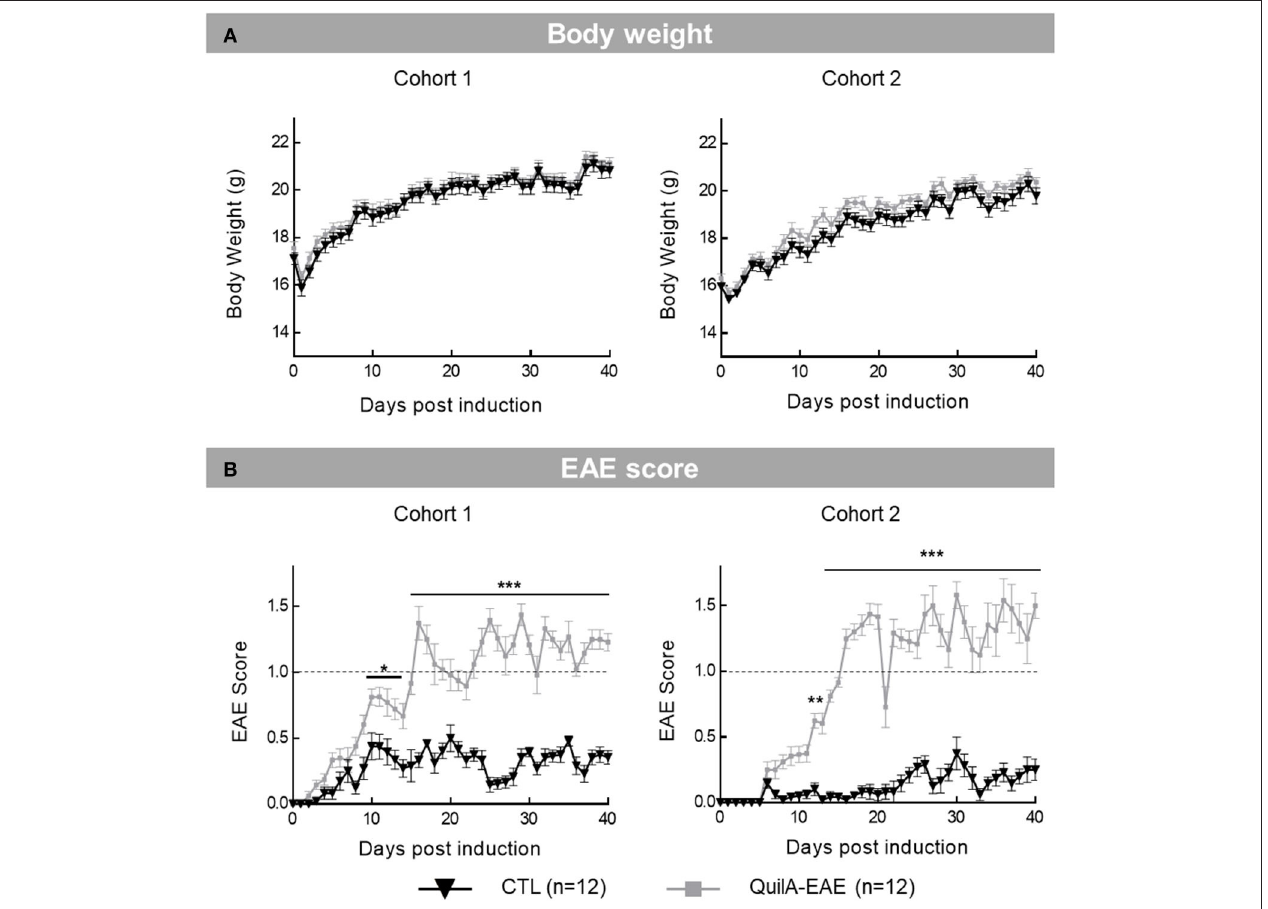
FIGURE 1 | Longitudinal monitoring of body weight and clinical scores in mice immunized with MOG 35 − 55 (QuilA-EAE) and their controls (CTL) from post-induction Day 0 (D0) to D40. (A) Time course of body weight. Results are means ± SEM. (B) Time course of EAE clinical score based on physical observation defined by Khan et al. ( 15) ranging from 0 (normal behavior) to 4 (quadriplegia). Results are means ± SEM. The dashed line represents level of motor defects considered as clinically relevant score (EAE score 1: completely limp tail or hindlimb weakness). Statistical analysis was performed using two-way ANOVA followed by post-hoc Sidak test; ** p < 0.01, *** p < 0.001 vs. control (shown for Sidak test only). * p <